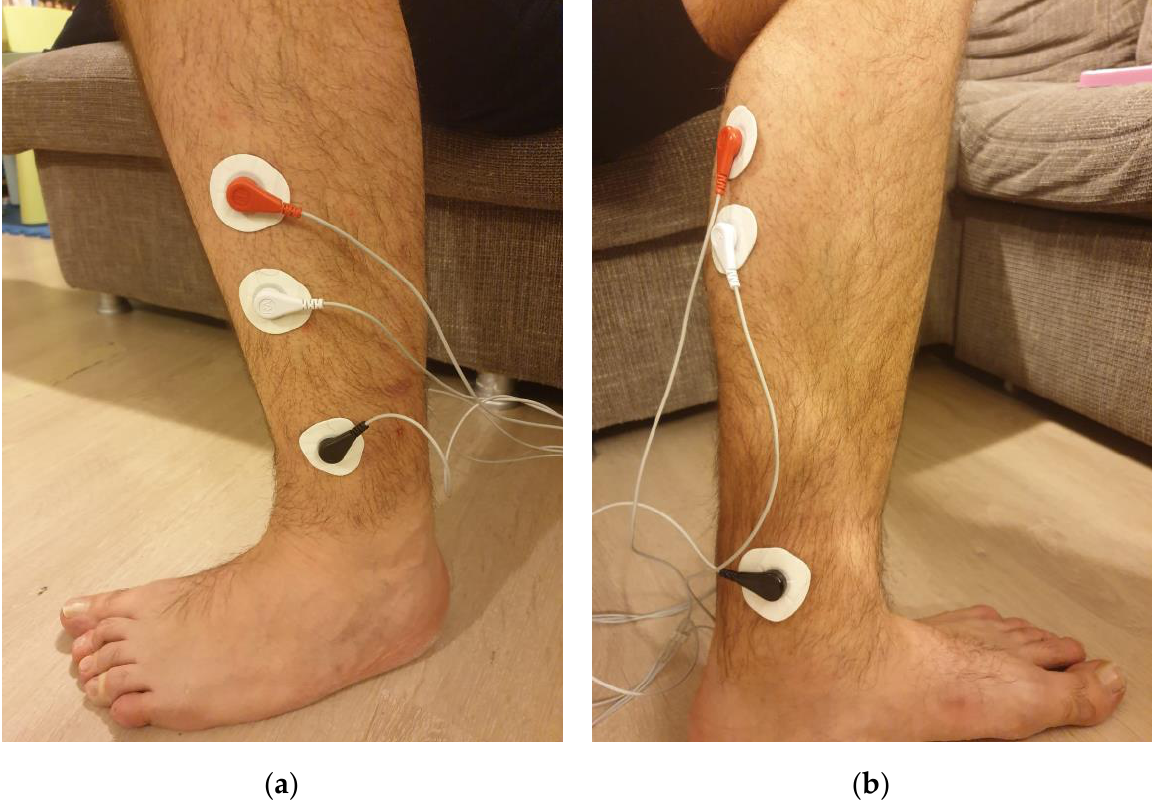
Figure 10. Electrode placement for lower-limb EMG acquisition of the ( a ) tibialis anterior, ( b ) gastrocnemius.